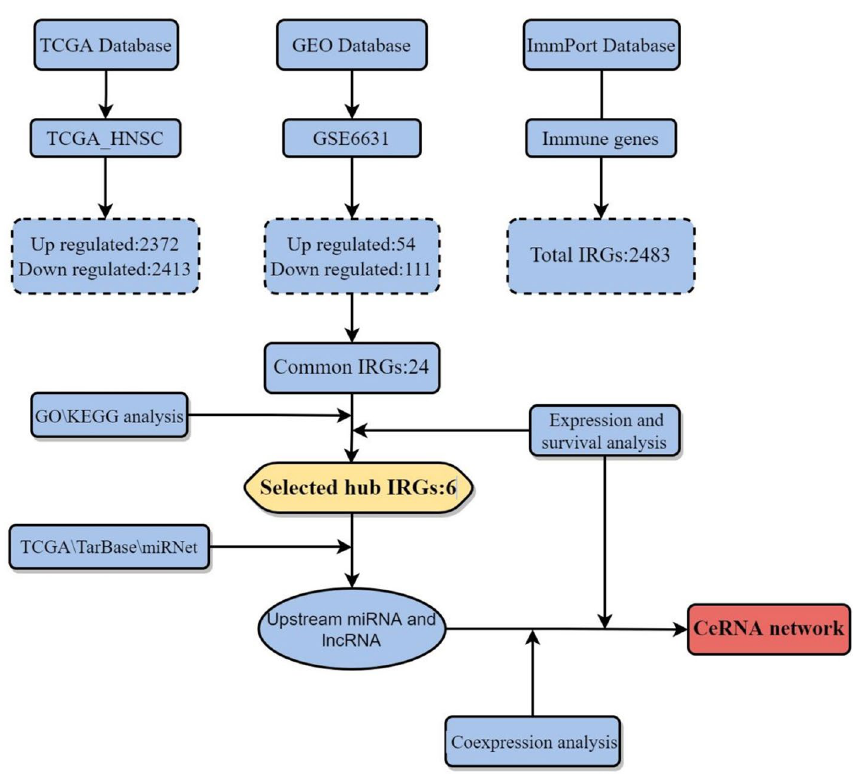
Figure 1. Flow chart of establishing and analyzing the immune-related ceRNA